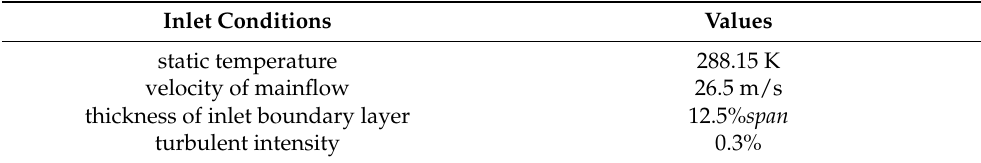
Table 2. CFD settings for the inflow condition of the cascade.